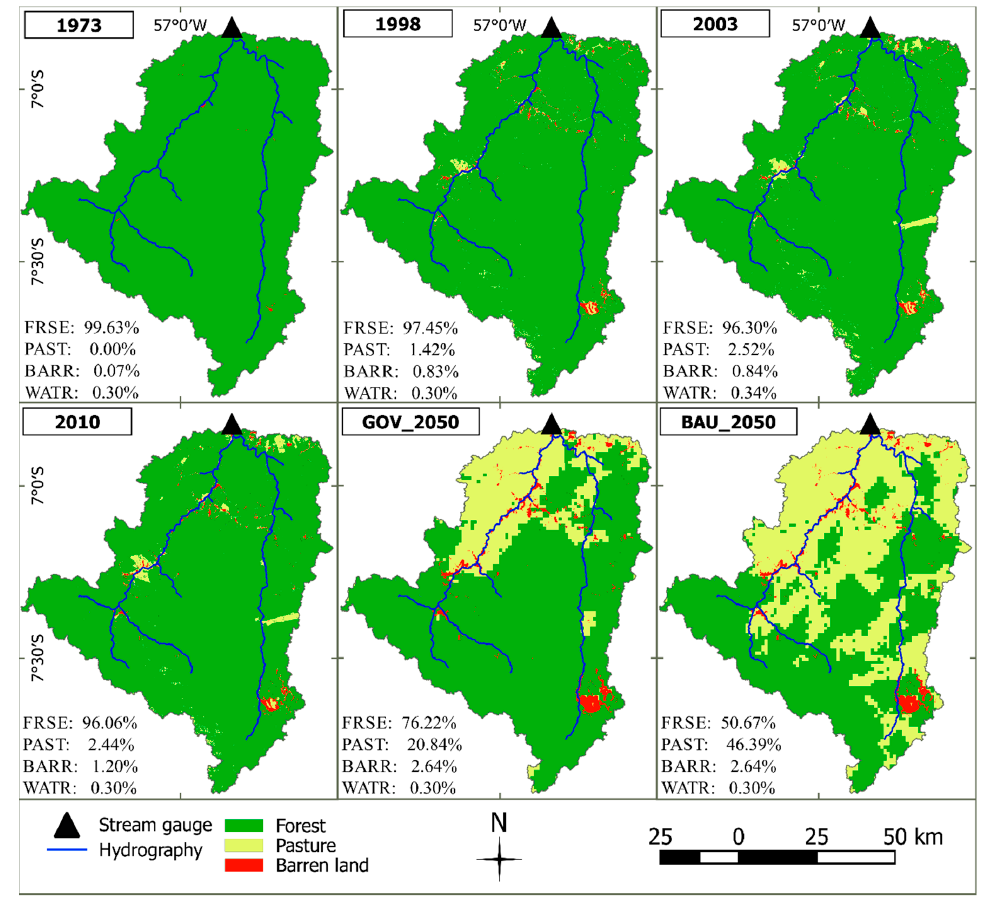
Figure 2. Land cover scenarios and land cover proportions in the basin’s area and scenarios used in the modelling. FRSE (Forest Evergreen), PAST (Pasture), BARR (Barren Land), and WATR (Open Water).